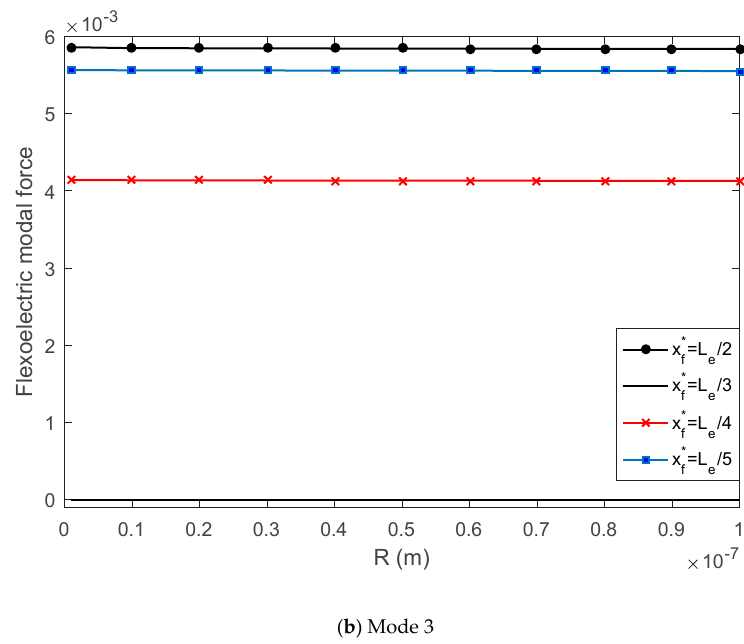
Figure 7. The effect of the probe radius on the flexoelectric modal force, ( a ) mode 1, ( b ) mode 3.